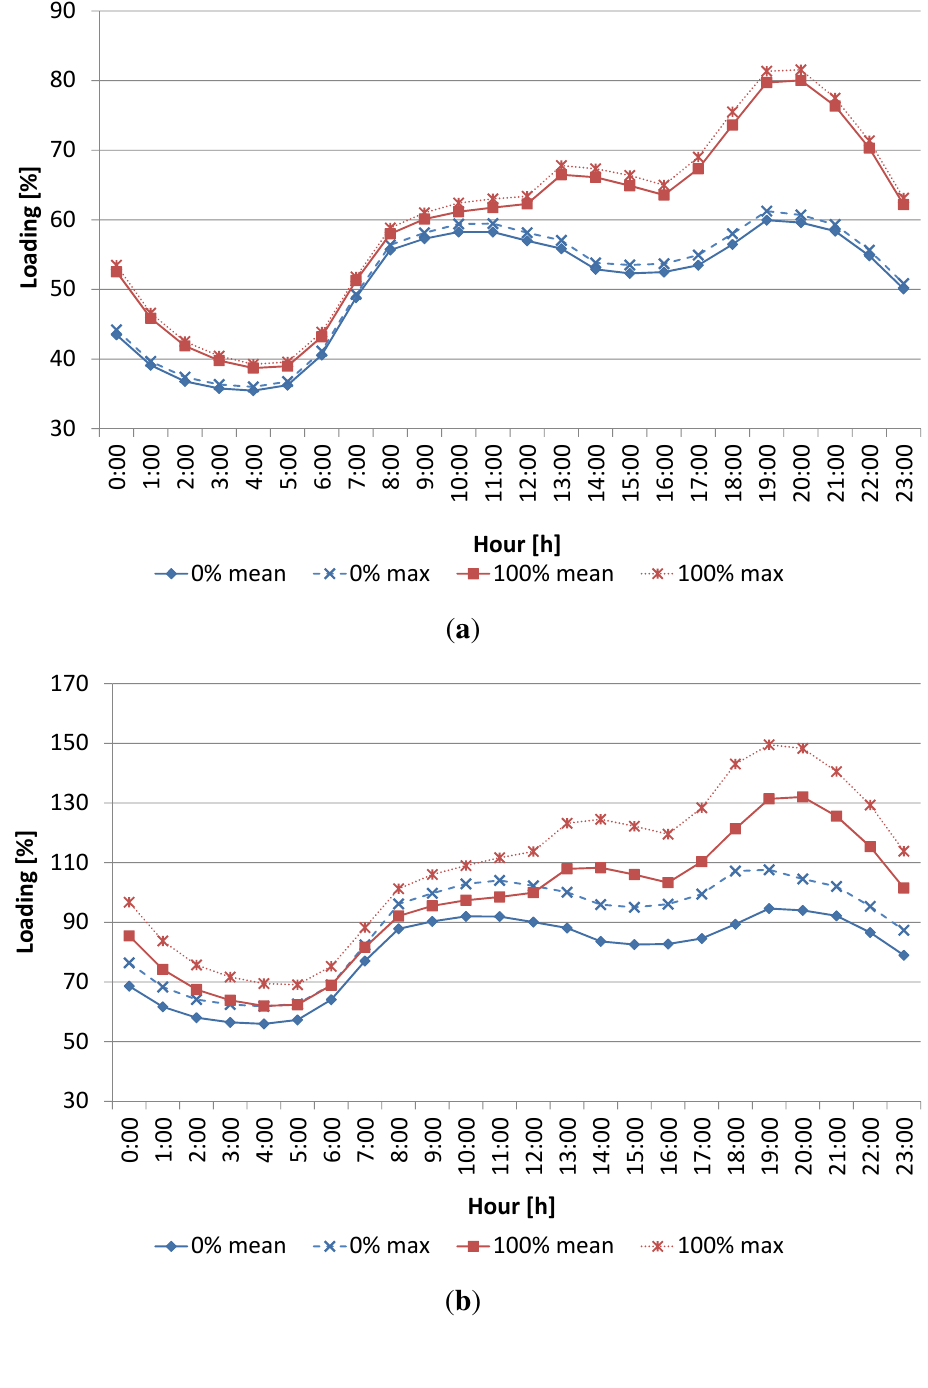
Figure 15. Grid’s loading profile with an EV’s penetration of 100% recharging at the end of all day travels. ( a ) Loading profile of the line L1; ( b ) Loading profile of the